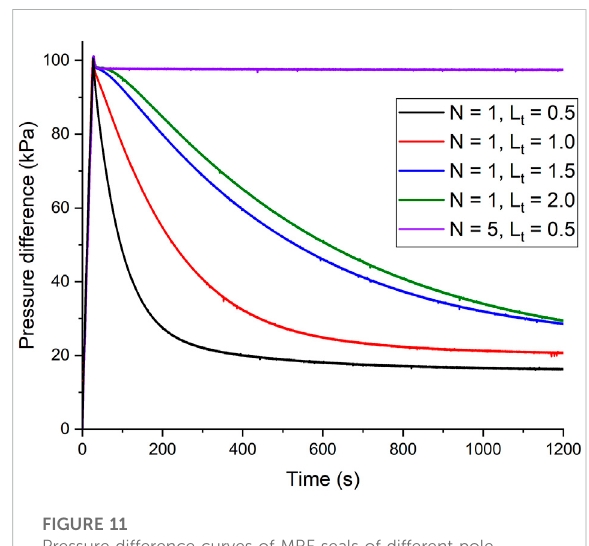
FIGURE 10 Pressure drops of MP seals of different pole pieces.